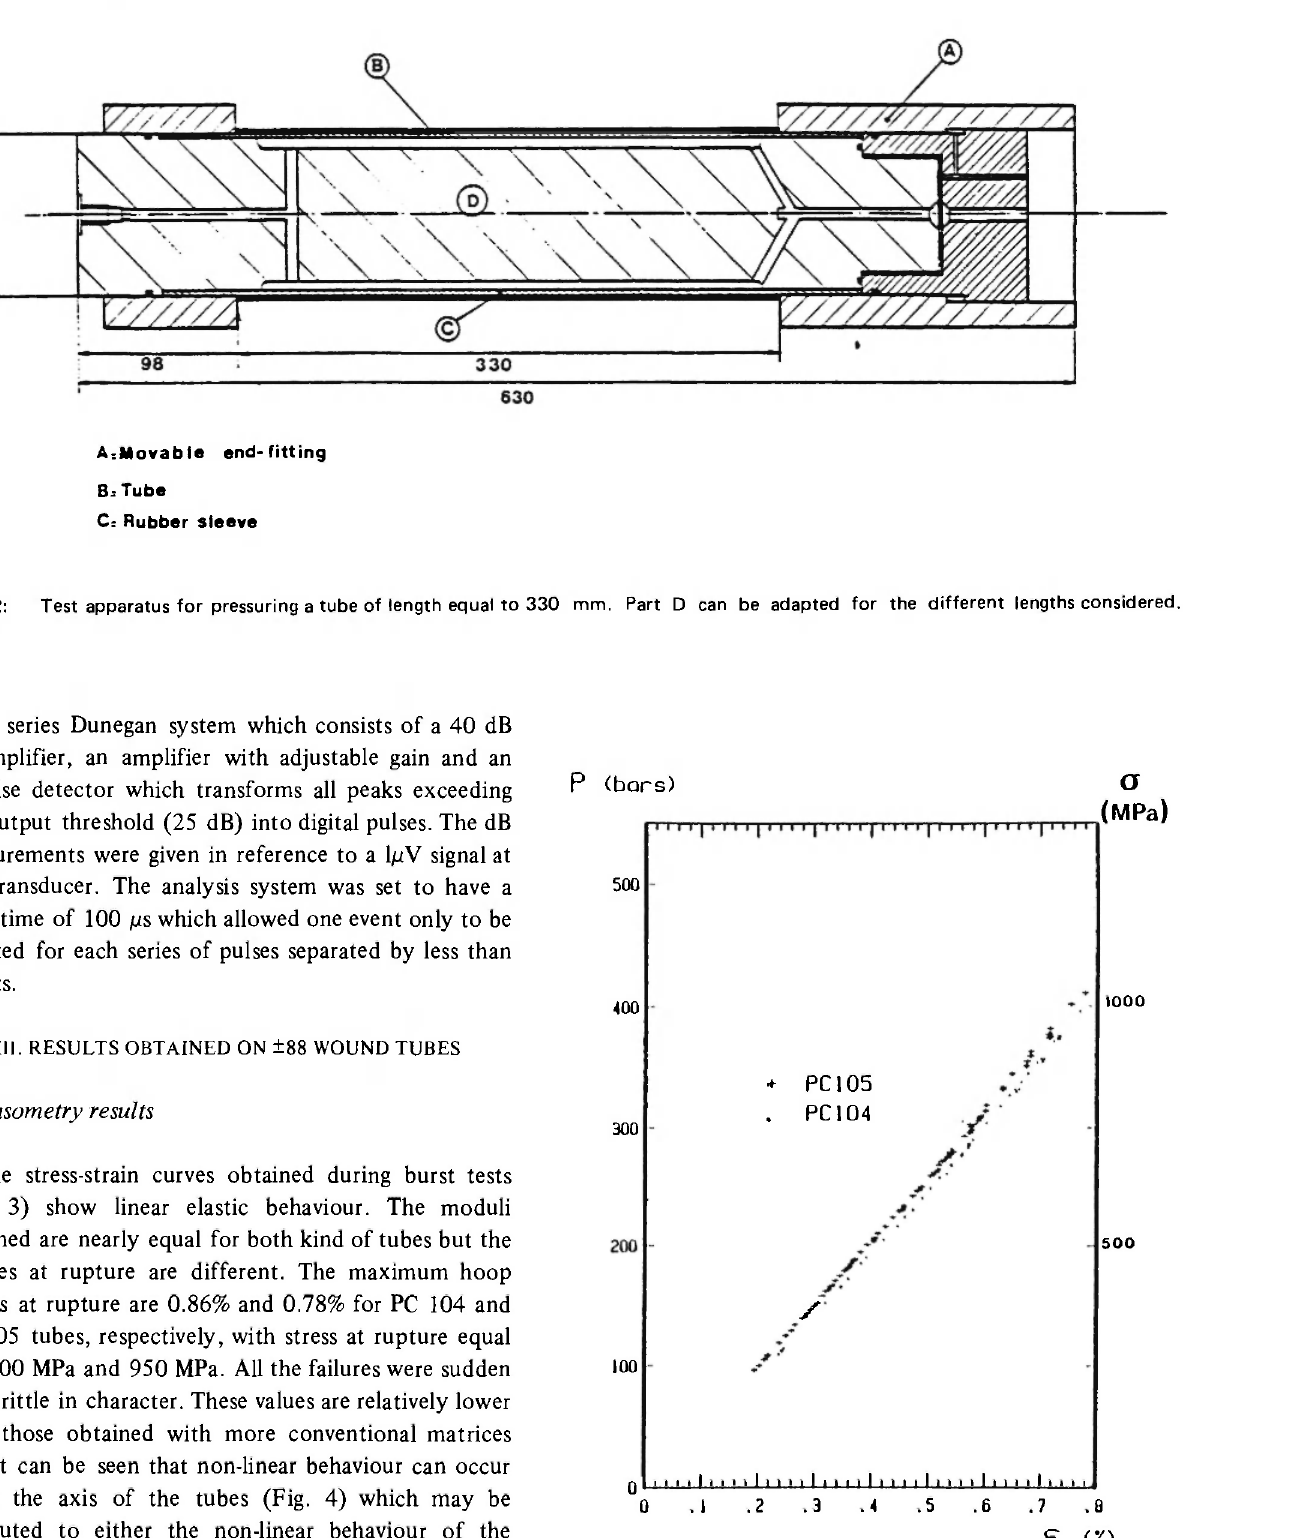
Fig. 3; Stress-strain curves obtained during burst tests of PC 104 tubes and PC 105